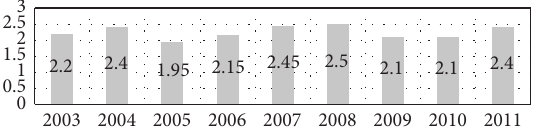
Figure 1: Total production of insulating mineral wools in Europe from 2003 to 2011 [2].